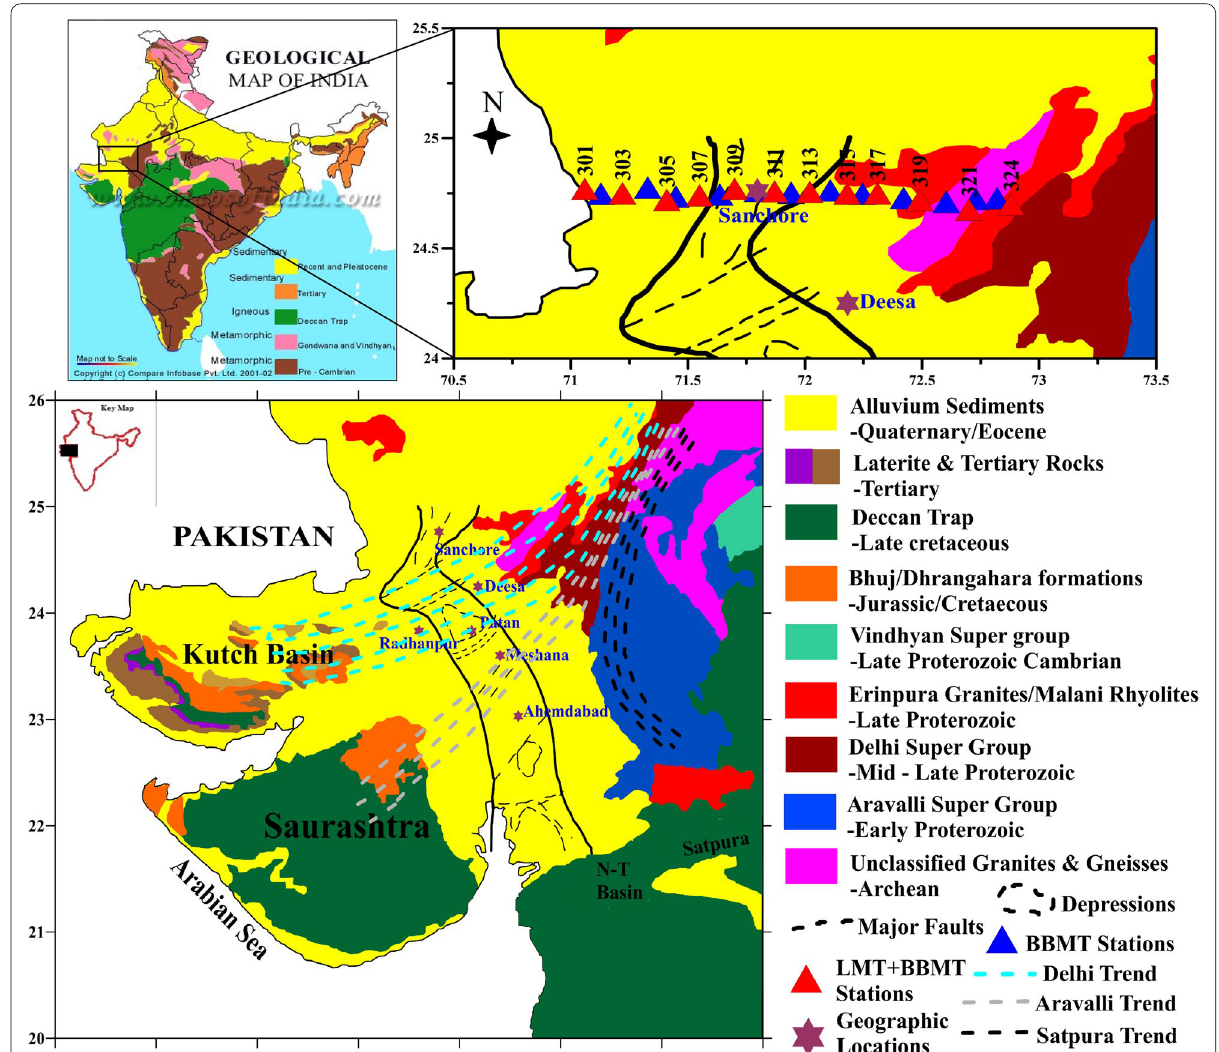
Fig. 1 Regional geological map of western continental margin of India (WCMI) (modified from Mishra et al. 1998; Biswas 1982, 1987). The top right panel shows northern Cambay basin showing locations of the MT profile. Red triangles represent LMT BBMT stations, and the purple stars represent major